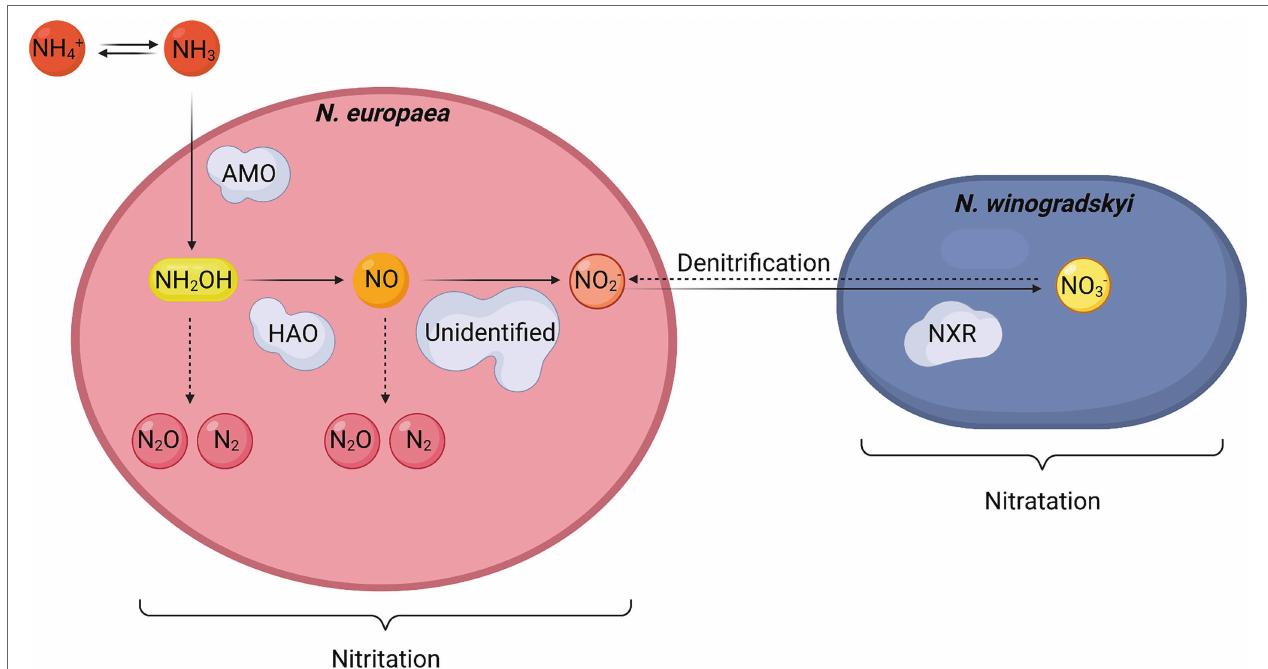
FIGURE 4 | Simplified schematic representation of the nitrification pathway in an axenic co-culture of Nitrosomonas europaea and Nitrobacter winogradskyi . Full lines represent nitrification in aerobic conditions. Dashed lines represent the denitrification pathway in anaerobic conditions. Abbreviations: AMO: ammonia monooxygenase, HAO: hydroxylamine oxidoreductase, NXR: nitrite